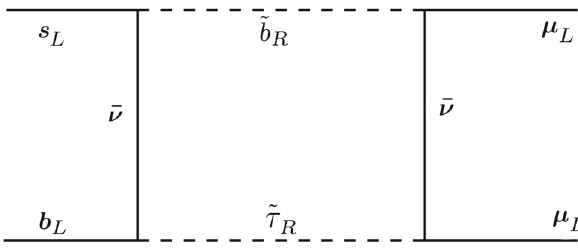
Fig. 1 The box diagram for b → s μ + μ − transitions with the combi- nation of both leptonic and leptoquark-like couplings